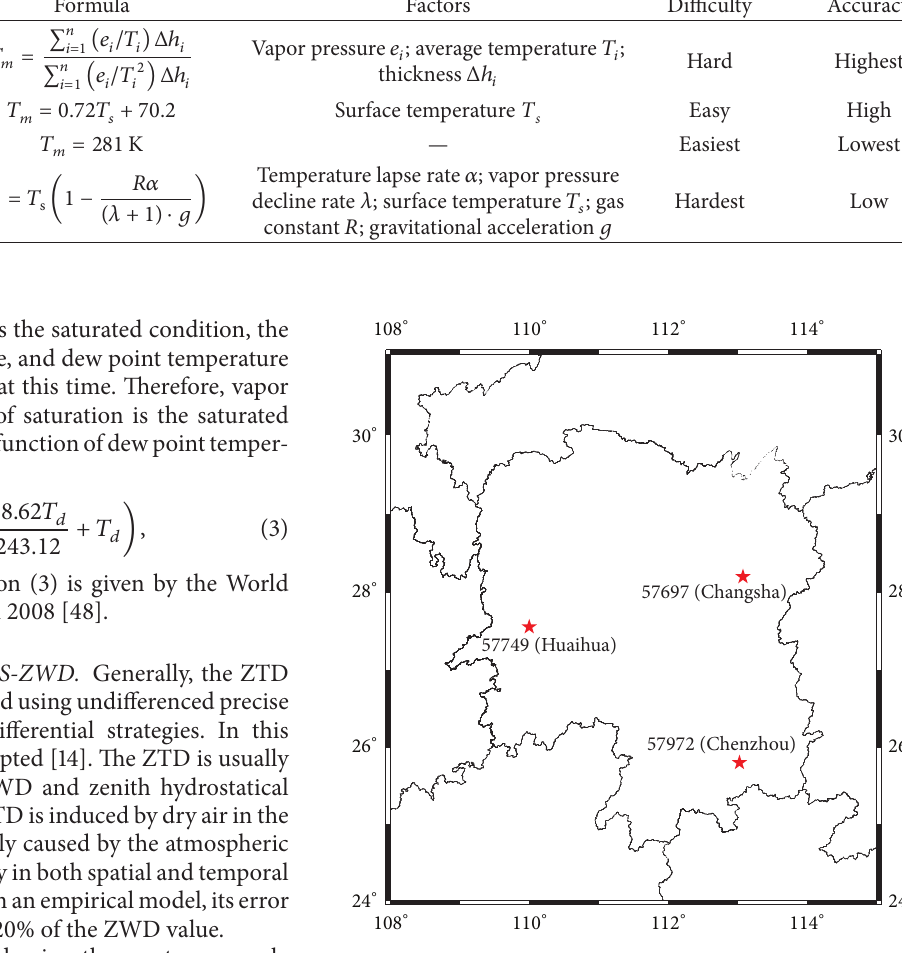
Figure1:LocationofthethreeradiosondestationsinHunanregion,